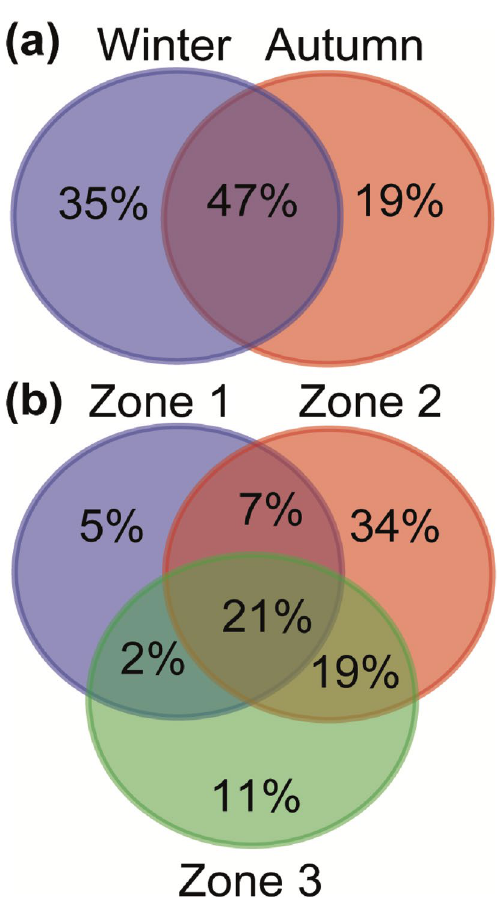
Figure 2. Percentage of shared and unique operational taxonomic units (OTUs) between different ( a ) seasons (autumn and winter) and ( b ) three climatic zones, for the fungal composition recovered from industrial grain mill